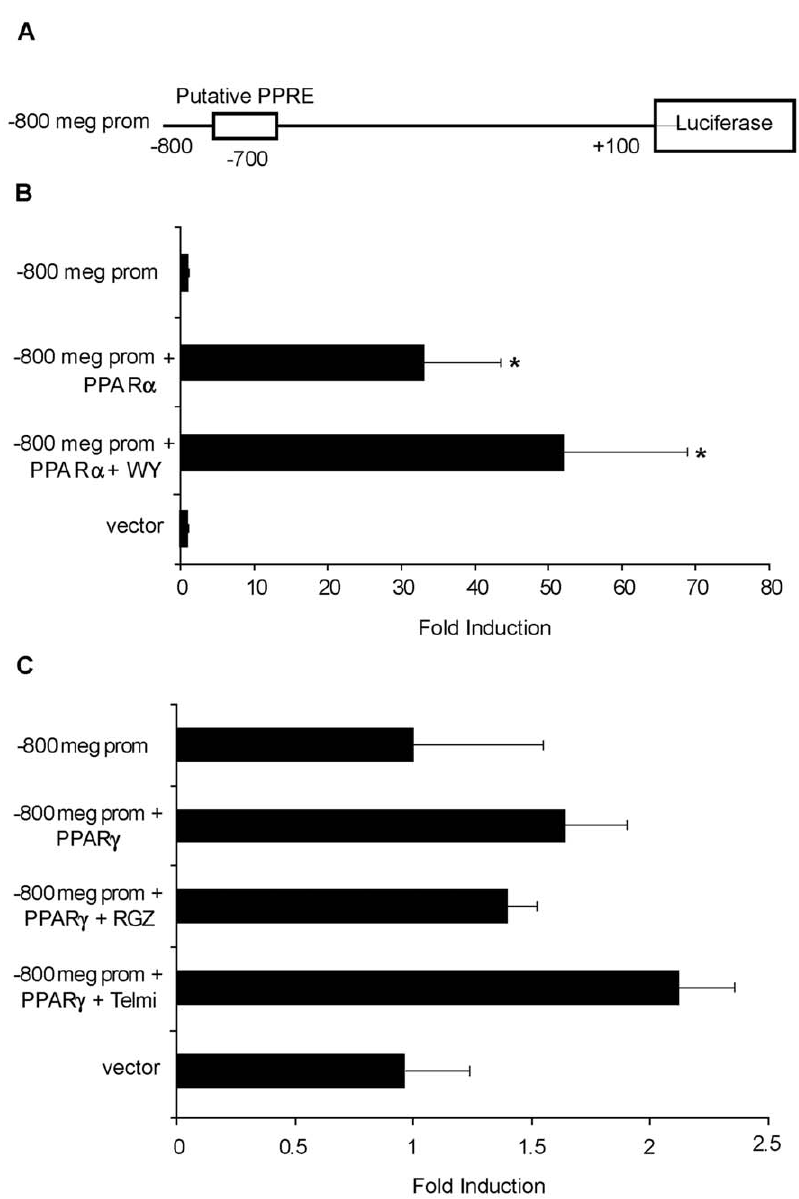
Figure 6. The first PPRE of the megalin promoter is activated by PPAR a , but not PPAR c . ( a ) Schematic of the construct used to analyze megalin promoter activity. ( b ) BN cells (6 6 10 4 cells) were seeded in 24-well plates in triplicate. The cells were transfected 24 h later with the megalin promoter construct ( 2 800 meg-Luc) and a b -galactosidase vector (pCMV b ). Cotransfections were performed by adding either PPAR a or PPAR c cDNAs. After 24 h, the transfected cells were treated with specific agonists for the PPARs and incubated for an additional 24 h prior to assaying the luciferase activity. Cells expressing the megalin promoter construct were able to increase luciferase activity 30-fold when PPAR a was overexpressed and nearly 50-fold when in addition to PPAR a , cells were treated with 100 m M WY 14643. ( c ) In contrast, overexpression of PPAR c with or without the corresponding ligands and treatment with rosiglitazone or telmisartan was unable to induce luciferase expression. Data are expressed as means 6 SD. *P , 0.05 vs. the 2 800 meg-Luc